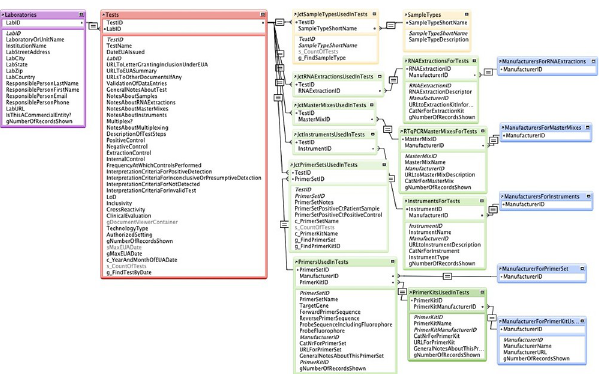
Fig 1. Main database architecture of EUAdb. Tables of data are related via one-to-many connections using a unique index field in each table, except for “join” tables that establish many- to-many connections via pairs of